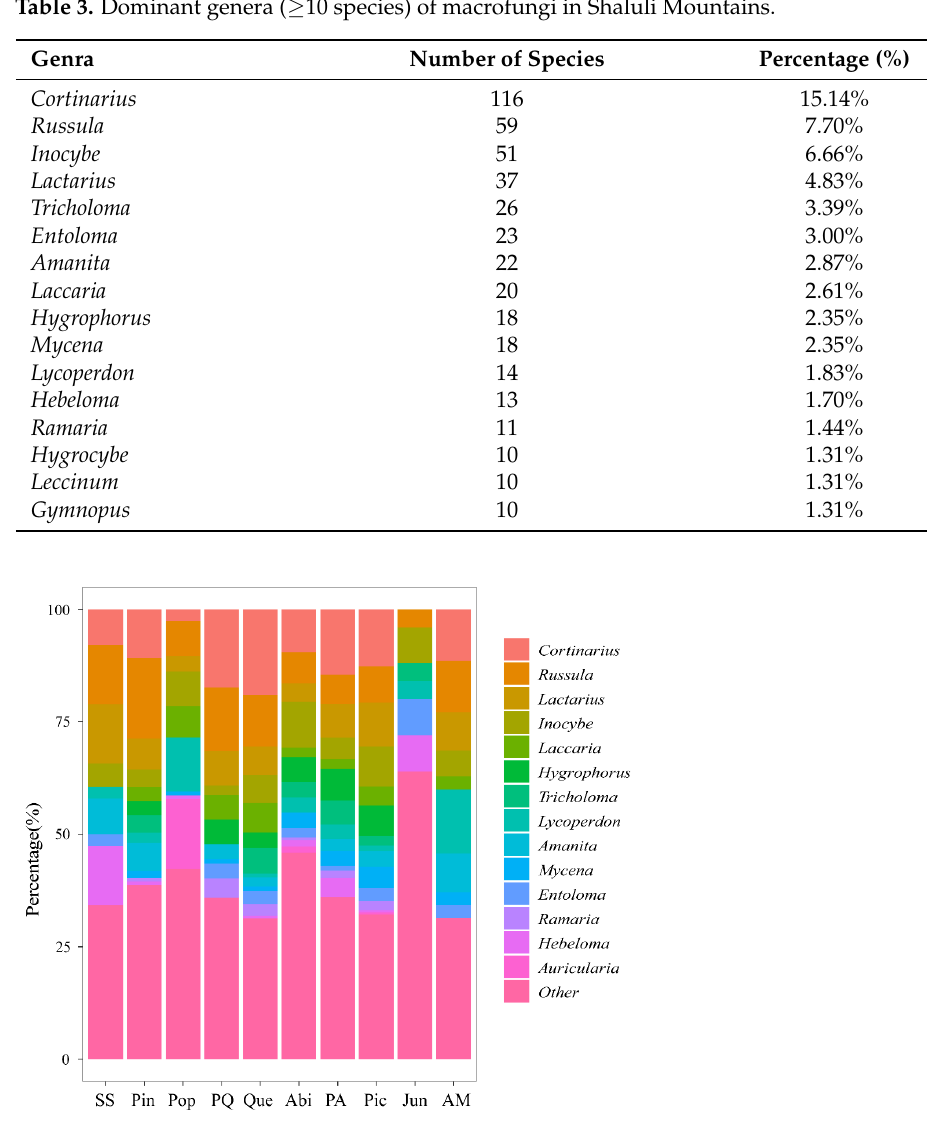
Figure 4. Photos of dominant genera. ( A ) Cortinarius aurantionapus ; ( B ) C. illuminus ; ( C ) Russula cf. emetica ; ( D ) R. cf. faustiana ; ( E ) R. cf. emetica ; ( F ) Lactarius alpinihirtipes ; ( G ) L. aurantiosordidus ; ( H )